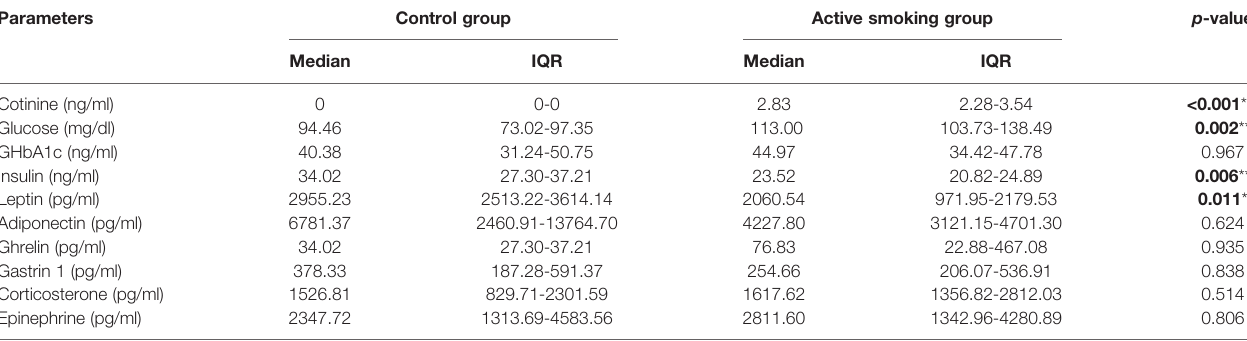
TABLE 1 | Comparison of serum parameters concentration between the control group and active smoking group.